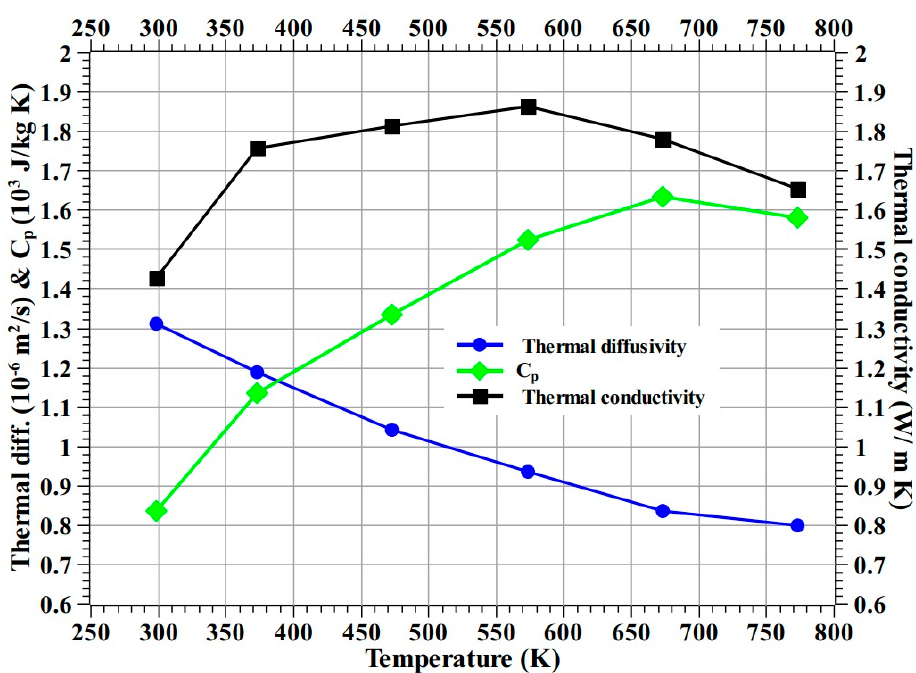
Figure 31. Thermophysical properties of 30° carbon phenolic up to 773.15 K (500 °C). Milos et al. [28] manufactured a dual-layer woven carbon phenolic material from a 3-D woven substrate and tested at various heat flux test conditions using plasma wind tunnels, including at 3.25 MW/m 2 , i.e., the same heat flux test condition as the CP (30 ◦ )-1 specimen. Here, in Figure 32, Milos et al. specimen’s temperature responses at 3.25 MW/m 2 were compared with the CP (30 ◦ )-1 specimen temperature responses. Compared to the CP (30 ◦ )-1 specimen, the fabrication techniques used by Milos et al. are more complex. The comparison shows the woven carbon phenolic material specimen’s exposed surface temperature (i.e., the stagnation point temperature measured by a pyrometer) was higher than that of the CP (30 ◦ )-1 specimen. Though, the CP (30 ◦ )-1 specimen’s internal temperatures at 20 and 30 mm, were higher than the woven carbon phenolic material’s internal temperatures at 20.32 and 25.4 mm, the CP (30 ◦ )-1 specimen’s internal temperatures at 10 mm is comparable with the woven carbon phenolic material’s internal temperatures at 10.16 mm. Overall, considering the complexity of the NASA’s dual-layer woven carbon phenolic material, the temperature responses of the CP (30 ◦ )-1 specimen are reasonable and